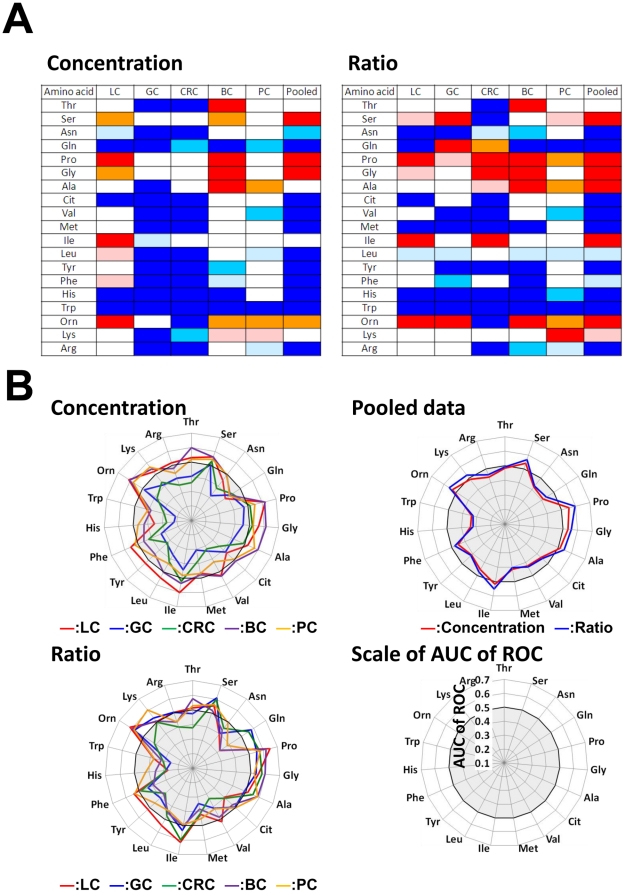
PFAA profiles of cancer patients.The results of the Mann-Whitney U-test (A) and receiver-operator characteristic (ROC) curve analysis (B) are indicated. A. Colored cells indicate that the concentration or ratio is increased in cancer patients at p<0.001 (red), p<0.01 (orange), and p<0.05 (pink), and decreased in cancer patients at p<0.001 (blue), p<0.01(sky blue), and p<0.05 (light blue), respectively. B. Axes show the AUC of ROC for each amino acid to discriminate patients from controls. Concentrations and ratios of each cancer patient and the pooled data set are indicated, respectively. Black bold lines indicate the point where the AUC of ROC = 0.5.